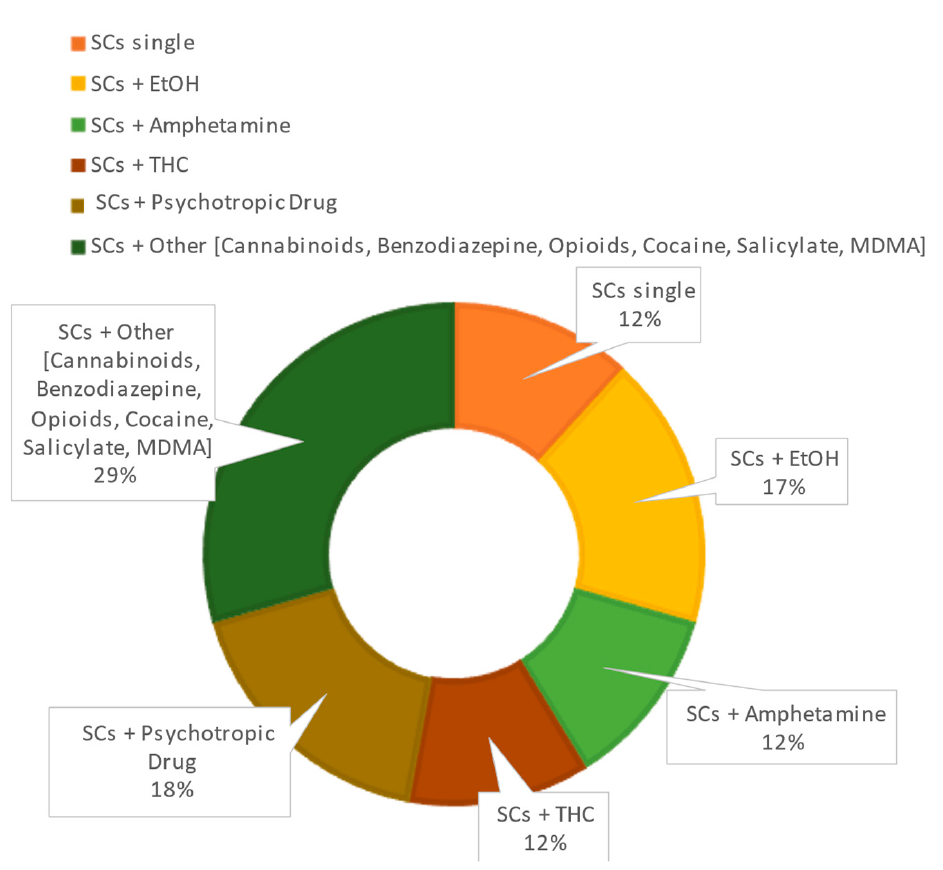
Figure 4. Distribution of other drugs of abuse in SC-related fatalities.